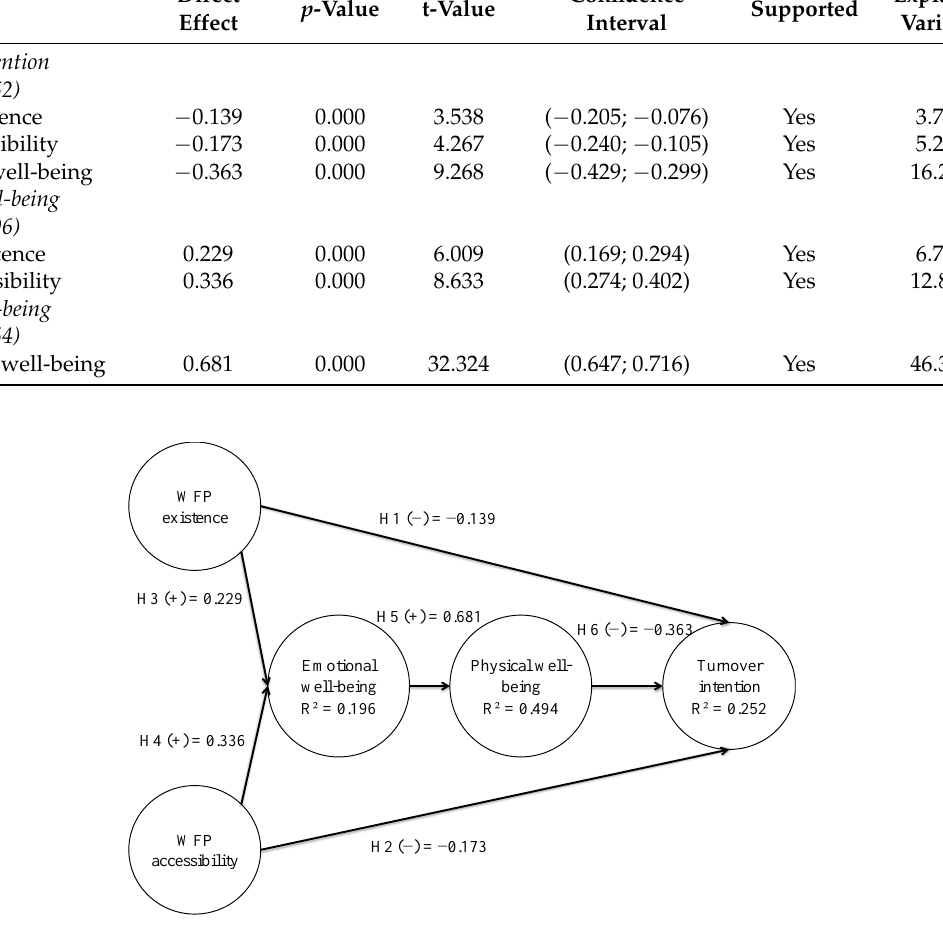
Figure 2. Direct effects. Diagram.